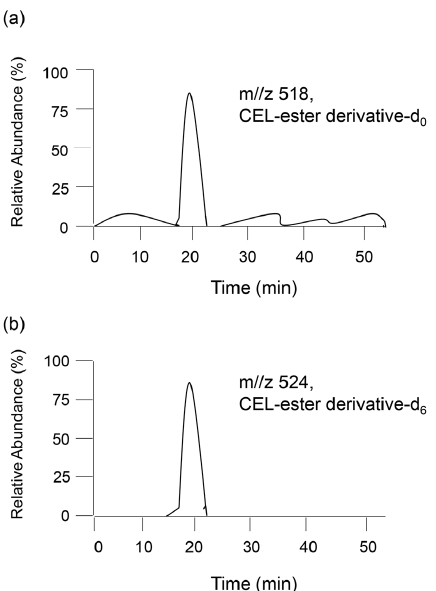
Figure 7. Model image of detection of ( a ) unlabeled CEL-ester derivative (CEL-ester derivative-d 0 ) in a sample and ( b ) deuterium CEL-ester derivative (CEL-ester derivative-d 6 ) as the standard for GC–MS analysis.